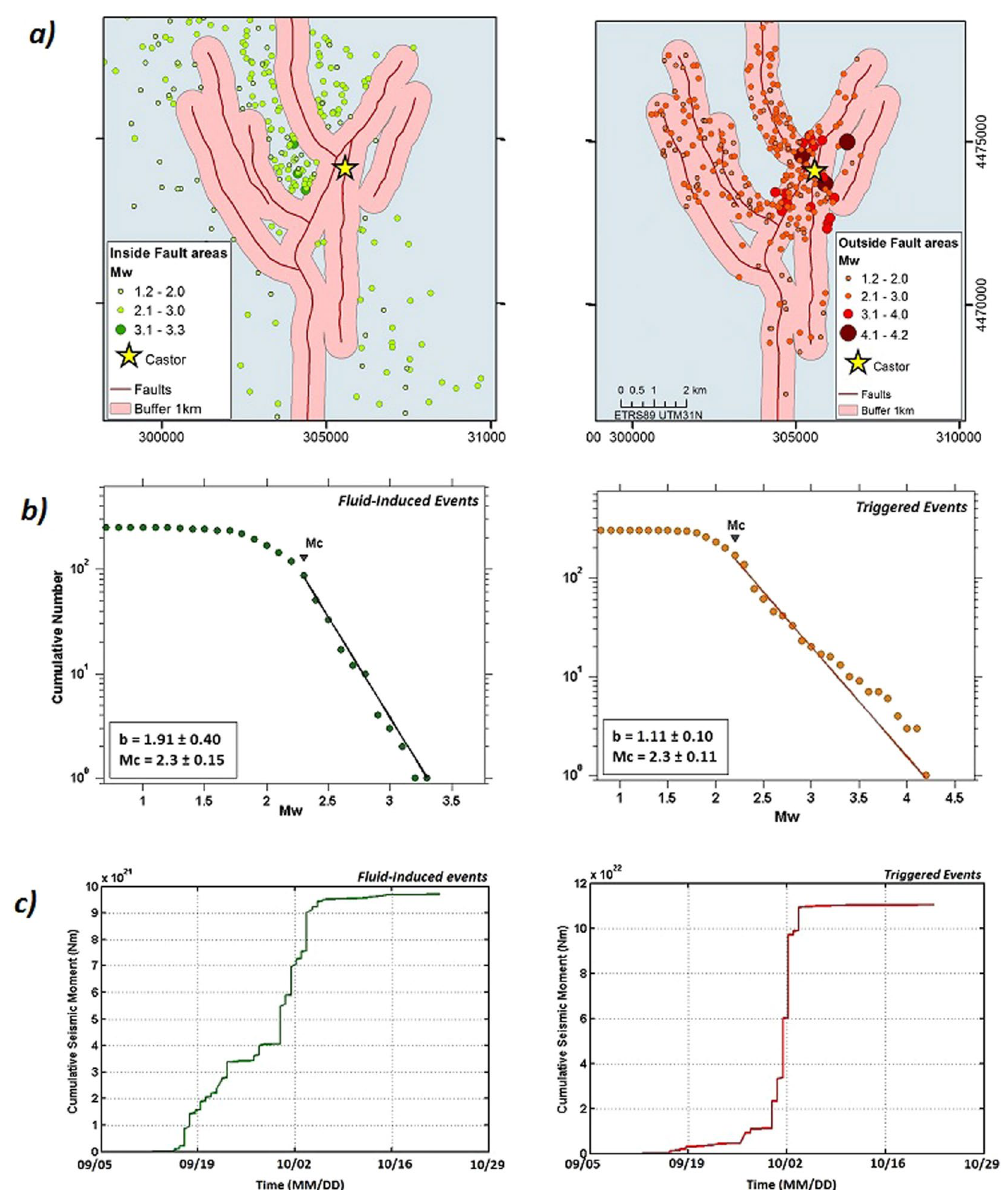
Figure 13. ( a ) Location maps of fluid-induced and triggered events. The criterion used to discriminate between both types of seismicity is their locations nearby/far from mapped faults (events outside a buffer area of 1 km around mapped faults are considered fluid-induced events and the triggered events are those inside the 1 km area around mapped faults). Fault traces have been digitalized from Cesca et al. 7 . Figure generated with ArcGIS for desktop, version 10.1. ( b ) Gutenberg-Richter laws for both types of seismicity and ( c ) Cumulative seismic moment releases from the fluid-induced and triggered events respectively. These figure were generated by using the ZMAP